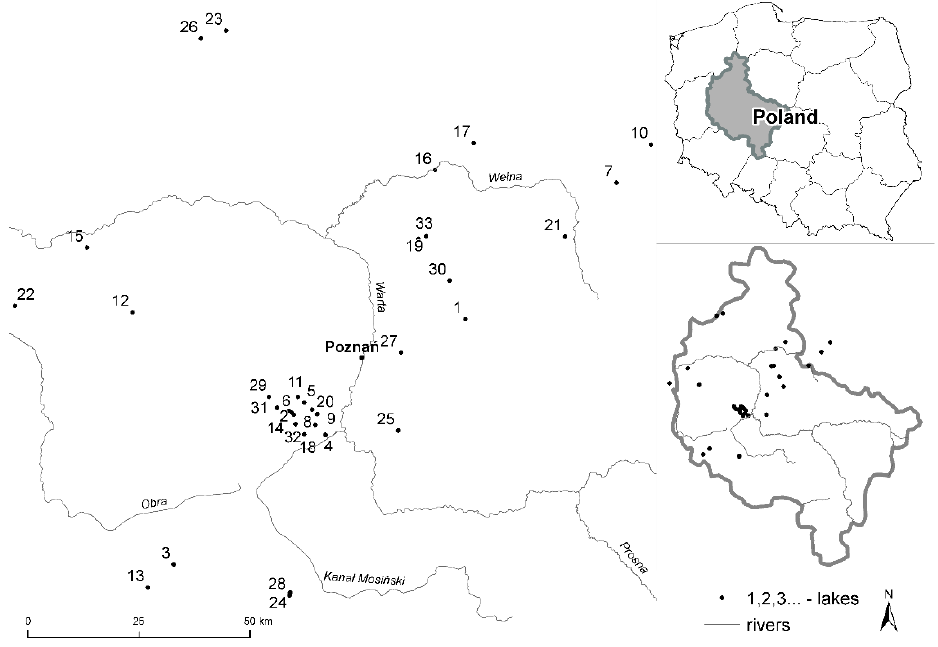
Figure 1. Localization of the lakes studied. Names of lakes are shown in Table